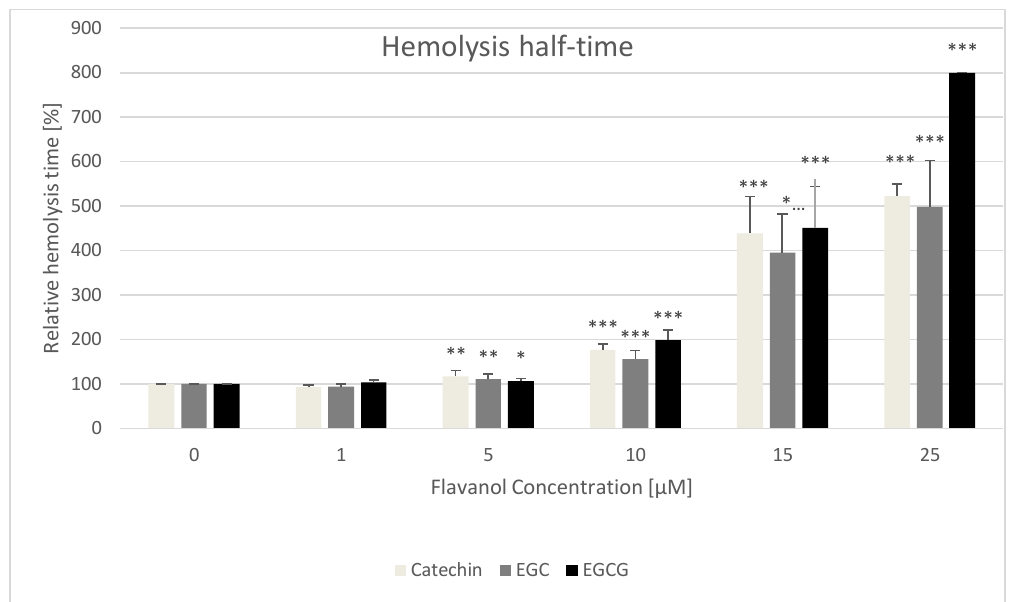
Figure 4. The exemplary curve of permanganate-induced hemolysis in the presence of various concentrations of catechin. E — erythrocytes; P — permanganate.